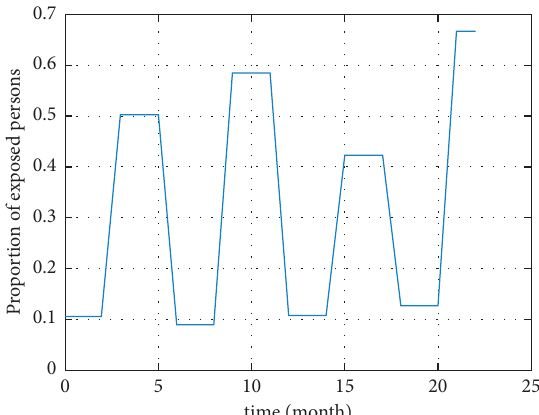
Figure 19: Proportion of the exposed people from March 2020 to January 2022.